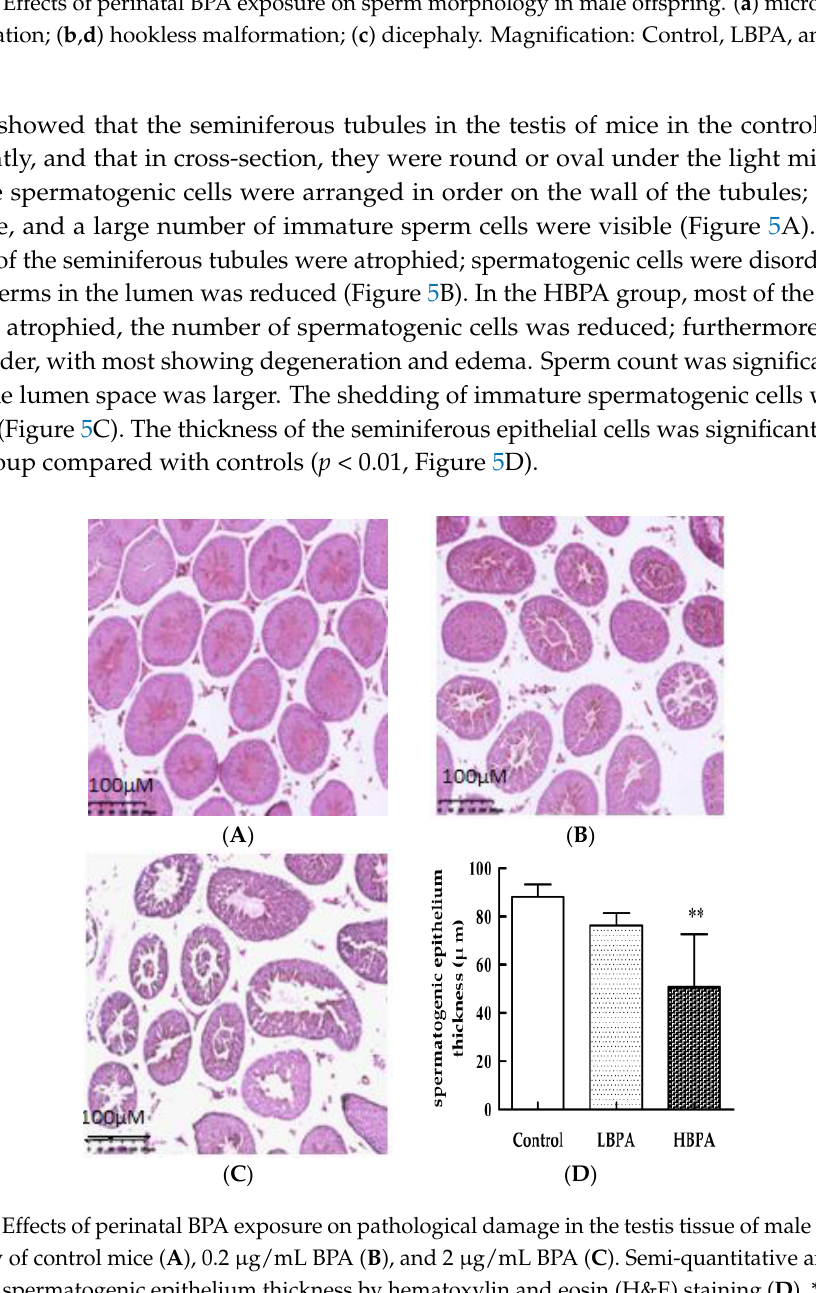
Figure 4. Effects of perinatal BPA exposure on sperm morphology in male offspring. ( a ) microcephalus